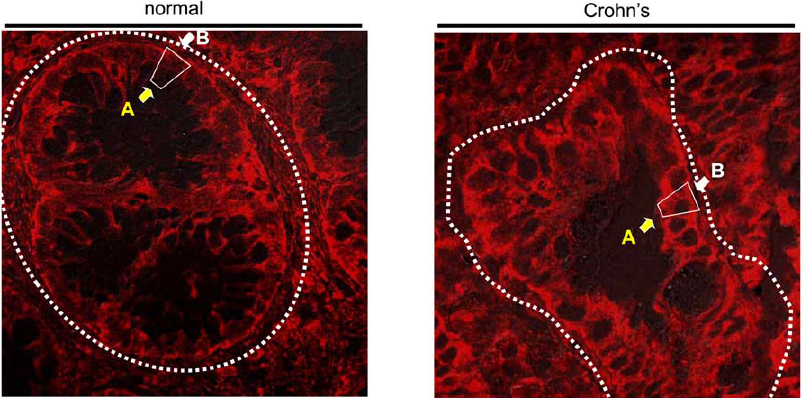
Figure 3. TfR is expressed at the apical aspect of the inflamed colonic epithelium in humans. Larger magnification ( 6 63) of (Figure 2B) immunostained for TfR. Left: a transverse section from non-inflamed colonic mucosa. Right: a transverse section from a Crohn’s disease patients, the basolateral membrane of the colon crypts is marked with white arrows, while the apical membrane is marked with yellow arrows.